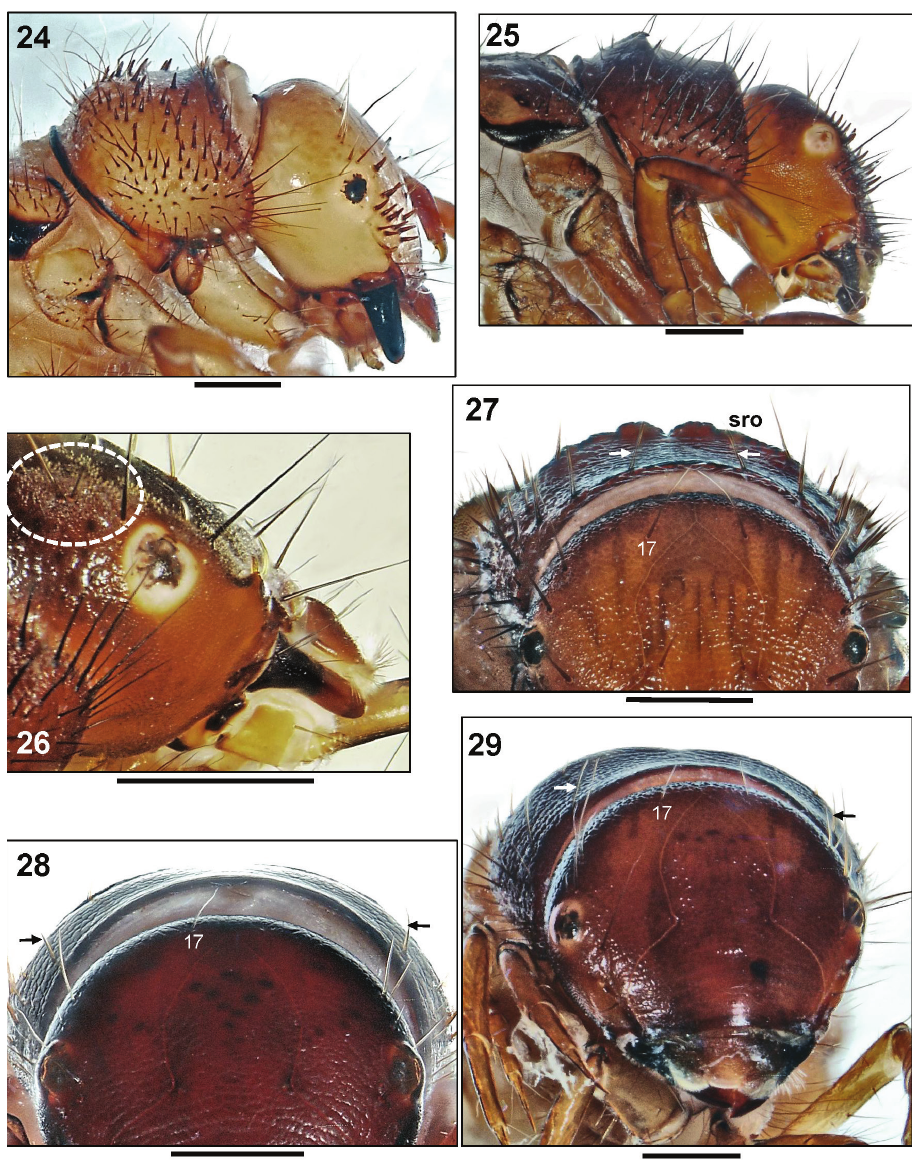
Figures 24–29. 24–25 Heads and pronota of 5 th instar larvae, right lateral views. 24 Ecclisopteryx dale- carlica Kolenati, 1848 25 Drusus botosaneanui Kumanski, 1968 26 Drusus serbicus Marinkovic-Gospod- netic, 1971, 5 th instar larva, head, right lateral view (dotted oval: spinule area). 27–29 Heads and pronota of 5 th instar larvae, frontal views. 27 Drusus nigrescens Meyer-Duer, 1875 (arrows: long dark setae reaching dorsal midline; sro: serrated outline of pronotal ridge; numbers refer to setal positions) 28 Drusus mixtus (Pictet, 1834) (arrows: long dark setae not reaching dorsal midline; numbers refer to setal positions) 29 Drusus aprutiensis Moretti, 1981 (arrows: long dark setae not reaching dorsal midline; numbers refer to setal positions). Scale bars: 0.5